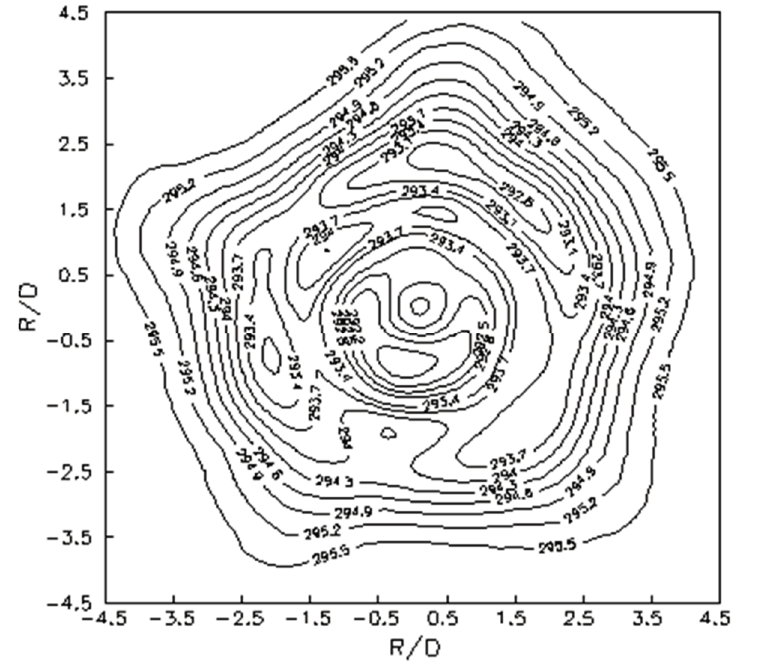
Figure 21. Adiabatic wall temperature on a plate with a normally impinging jet. D = 5 mm; z/D = 4; M = 0.78; Re = 86,400. From Meola et al .